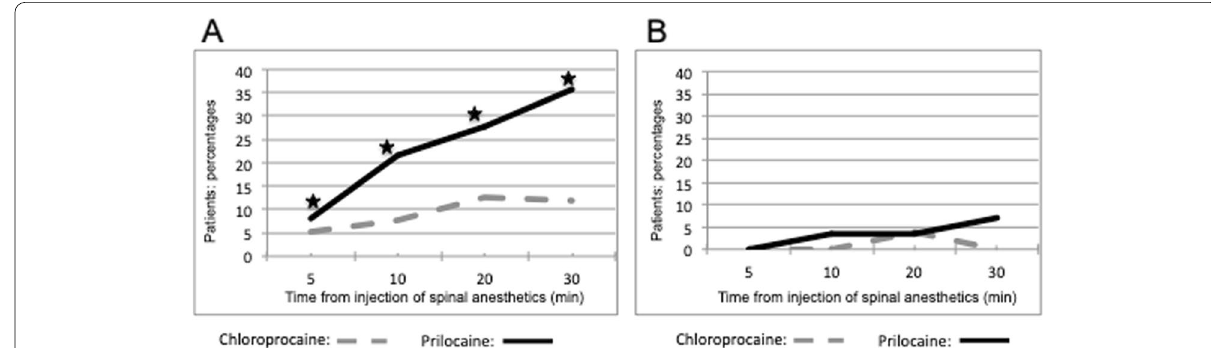
Fig. 4 a Percentage of patients with a complete loss of cold sensation at T4 dermatome level during the first 30 min after local anesthetics injection. b Percentage of patients with negative pin-prick test at the T4 dermatome level during the first 30 min after local anesthetics injection. Statistically significant differences are marked with *( P <